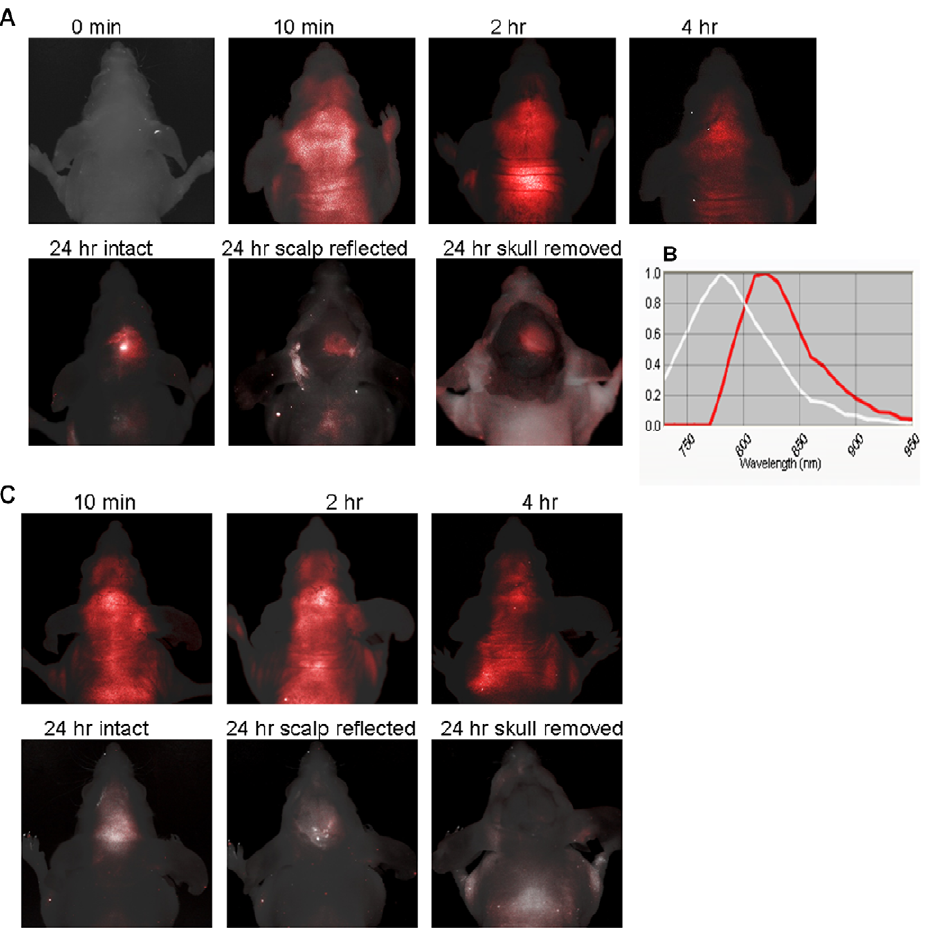
Figure 3. Dynamic invivo fluorescence imaging of the 2-DG dye uptake by intracranial glioma. A. After i.v. injection of IRDye800CW 2-DG repeated in vivo fluorescence imaging was performed. During the first four hours, unmixed images showing stronger signal of the dye in the brain area, but there was no obvious contrast between the tumor side of the brain and the normal brain. However, 24 h later, the light signal remained only in the tumor side of the intact brain. Even better contrast was seen after reflection of the scalp or further removal of the skull. B. Normalized emission spectra showing the near infrared 2-DG dye with a peak emission wavelength at 810 nm (red), while the background signal (white) was at , 770 nm. C. As a control of the 2-DG dye, IRDye800CW carboxyl was injected into a mouse bearing orthotopic glioma. No significant difference in light intensity between the two sides of the brain was observed at any time points.